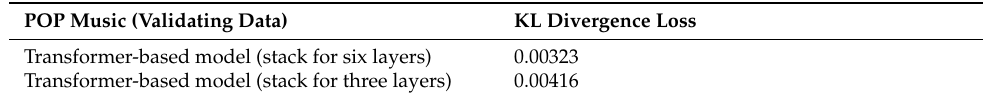
Table 3. Results with popular music dataset.